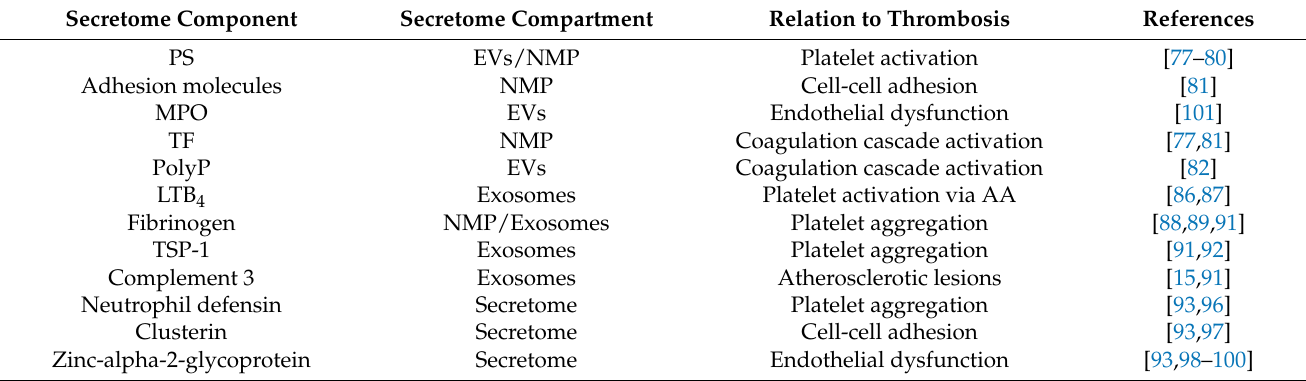
Table 1. Secretome components that could trigger